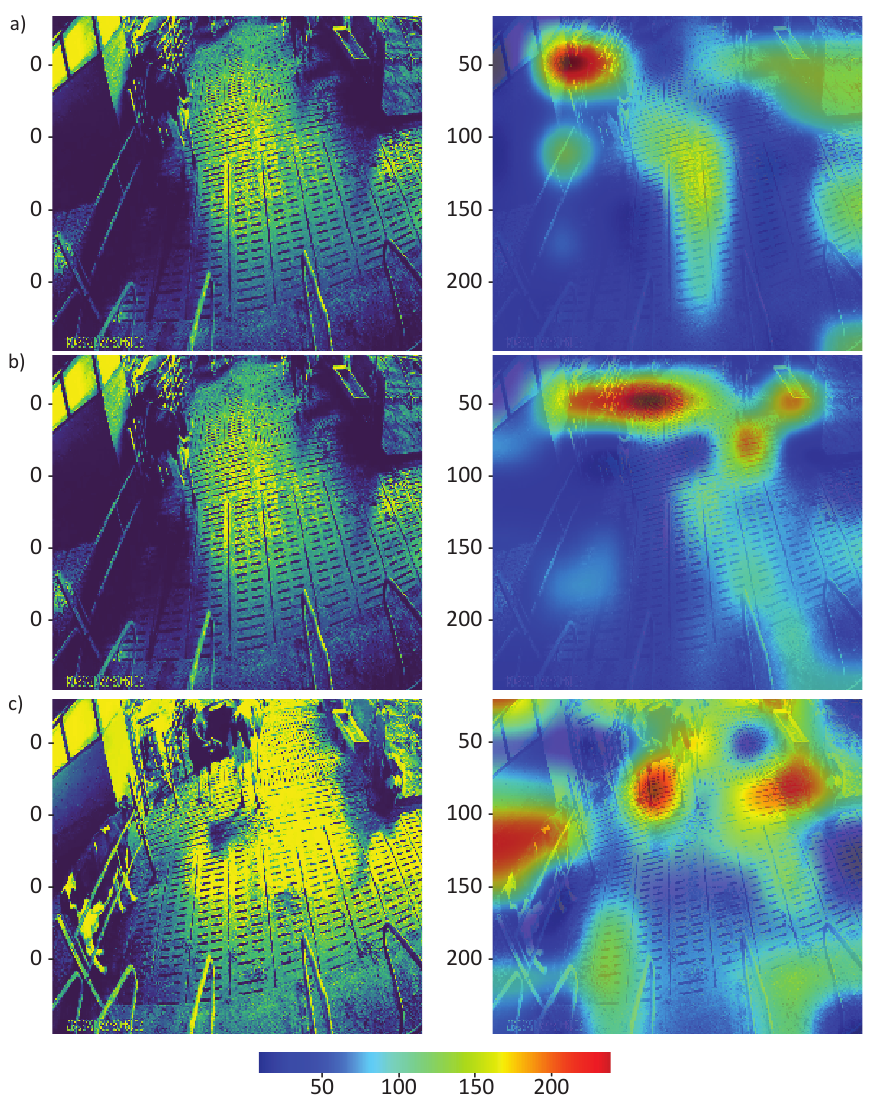
Fig. 10. Images (a) and (b) are from video 1569153540.mp4 frame 6229, classes curiosity and drink, respectively. Image (c) is from video 1569146340 frame 489, class interaction lateral. Note that the alignment between the heatmap and image is not